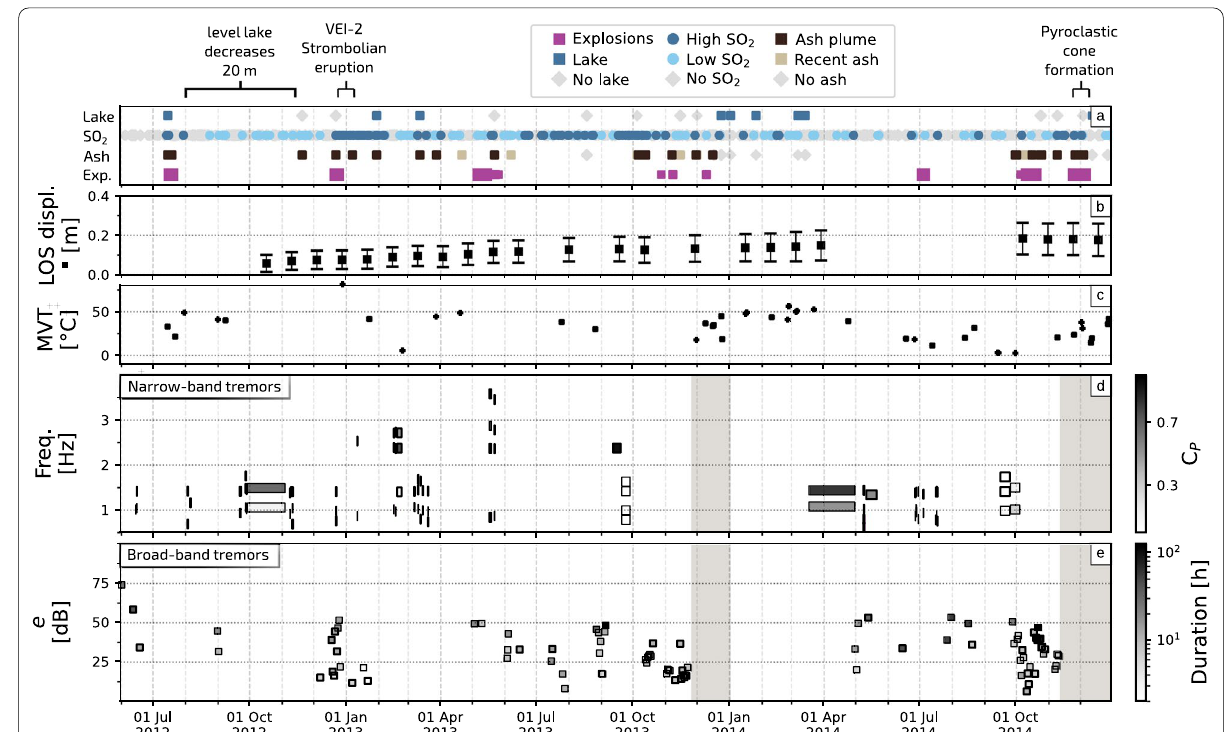
Fig. 10 Time evolution of ( a ) surficial activity, b LOS-displacement, c LST temperature, d frequency and C P of dominant frequencies of NB tremors, and e energy of BB tremors for the periods June 2012 to December 2014. Gray shadows in c and d depict periods without seismic